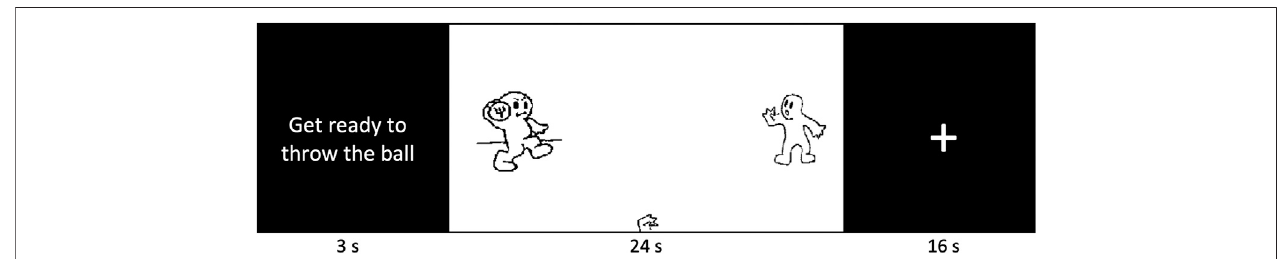
FIGURE 2 | Cyberball paradigm.